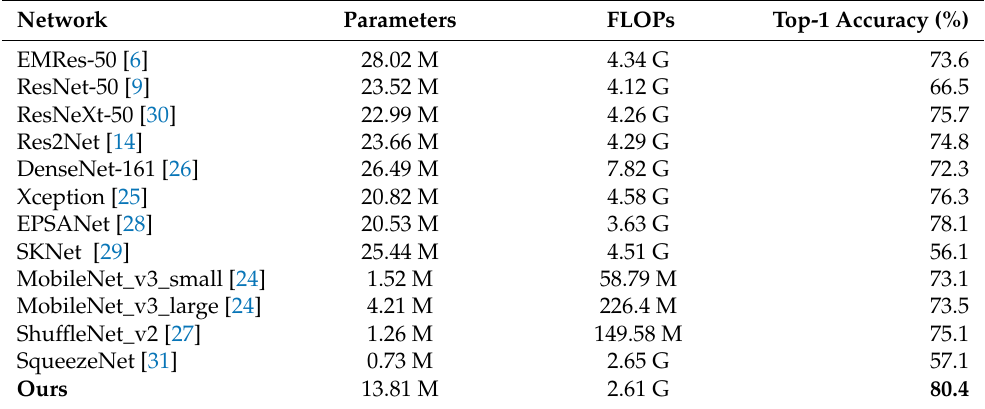
Table 5. Comparative experimental results of MFANet and various neural networks on the Collar6